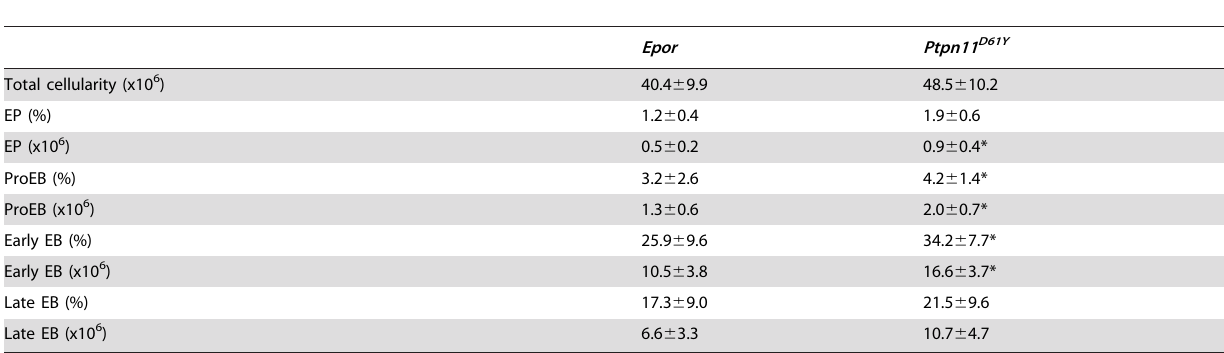
Frequencies and absolute numbers of BM erythroid cells from Epor (n=6) and Ptpn11 D61Y mice (n=9) mice. Data are presented as means 6 SD (* p , 0.05, by ANOVA). doi:10.1371/journal.pone.0109682.t002 PLOS ONE |